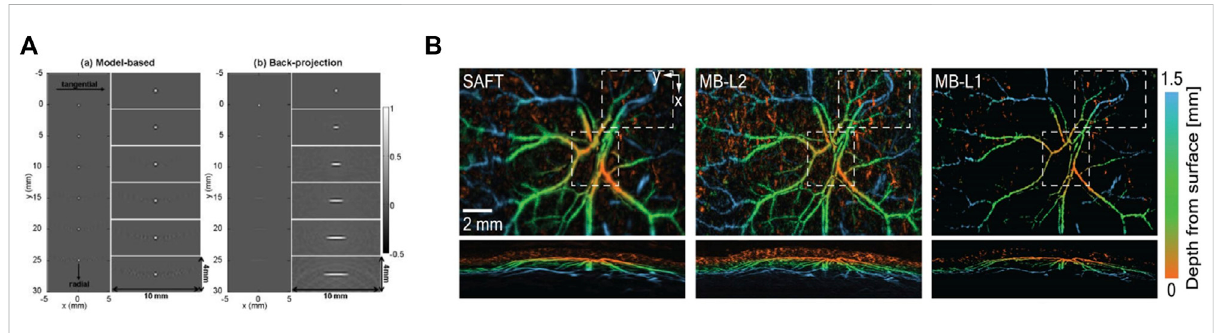
FIGURE 4 Accounting for the fi nite aperture of the ultrasound transducer. (A) Comparison of the optoacoustic (OA) images reconstructed with MB and fi ltered back-projection (FBP) algorithms considering the simulated signals for a fl at transducer circularly scanned around the sample. Reprinted from [103] with permission from Optica Publishing Group. (B) Comparison of the OA microscopy images of the subcutaneous murine vasculature obtained with a FBP-based synthetic aperture focusing technique (SAFT, left), a MB algorithm considering a L2-norm regularization term (middle) and a MB algorithm considering a L1-norm regularization term (right). Reprinted from [76] with permission from Wiley Online